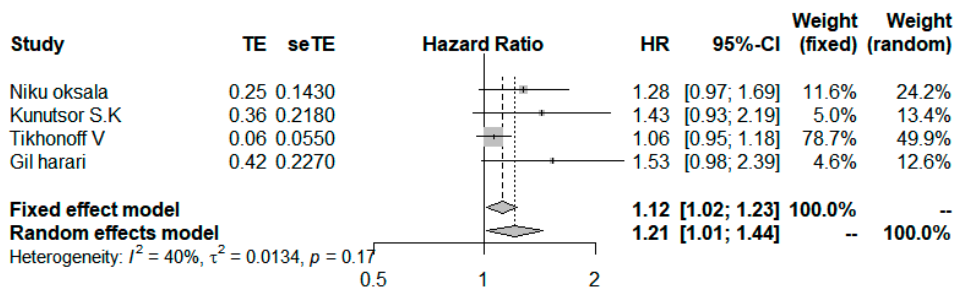
Figure 7. Forest plot for pooled HRs and 95% CIs of CVD mortality for highest versus lowest categories of serum Low-density lipoprotein cholesterol (LDL-C) level [26,27,30,33]. The overall effect was obtained from a random-effect model.